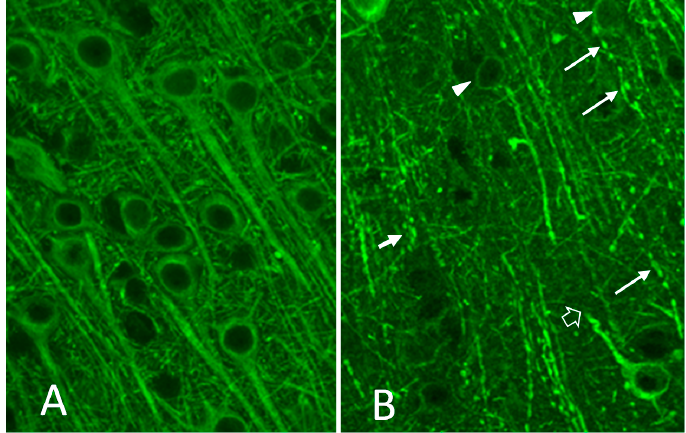
Figure 2. Stain for MAP-2 (green) in the cortex of an FIV-infected cat: ( A ) example of normal cortical pyramidal cells; and ( B ) adjacent areas often show early signs of damage indicated by a fragmented appearance of the MAP-2 stained dendrites and signs of focal swelling.